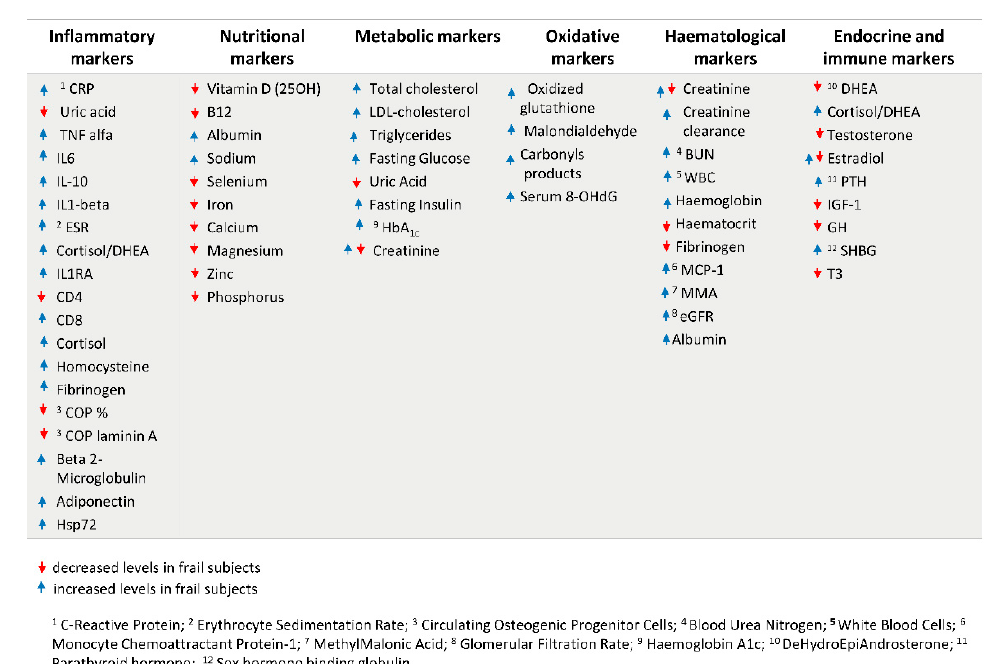
Figure 3. Circulating biomarkers of frailty divided in six sets of physiological parameters. The red and blue arrows indicate if increased or decreased levels were found in frail subjects, according to literature evidence, as reported in the text.